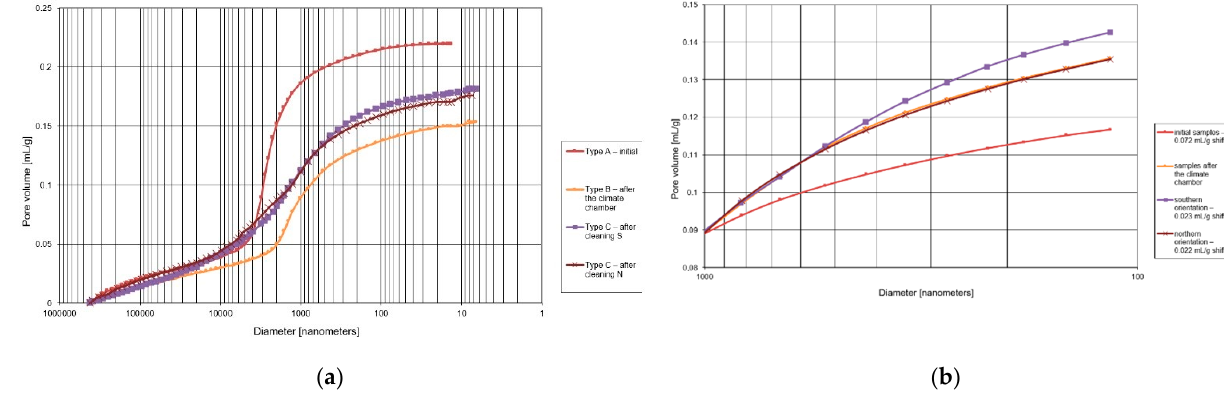
Figure 8. Differential curves of pore distribution for mineral-based plaster.